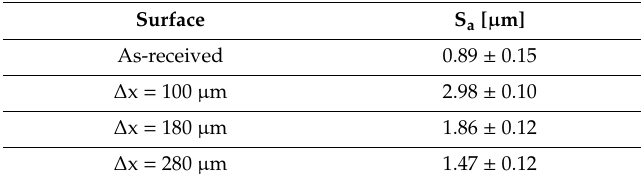
Table 1. Average surface roughness parameter S a of as-received and laser-textured Ti-6Al-4V surfaces.